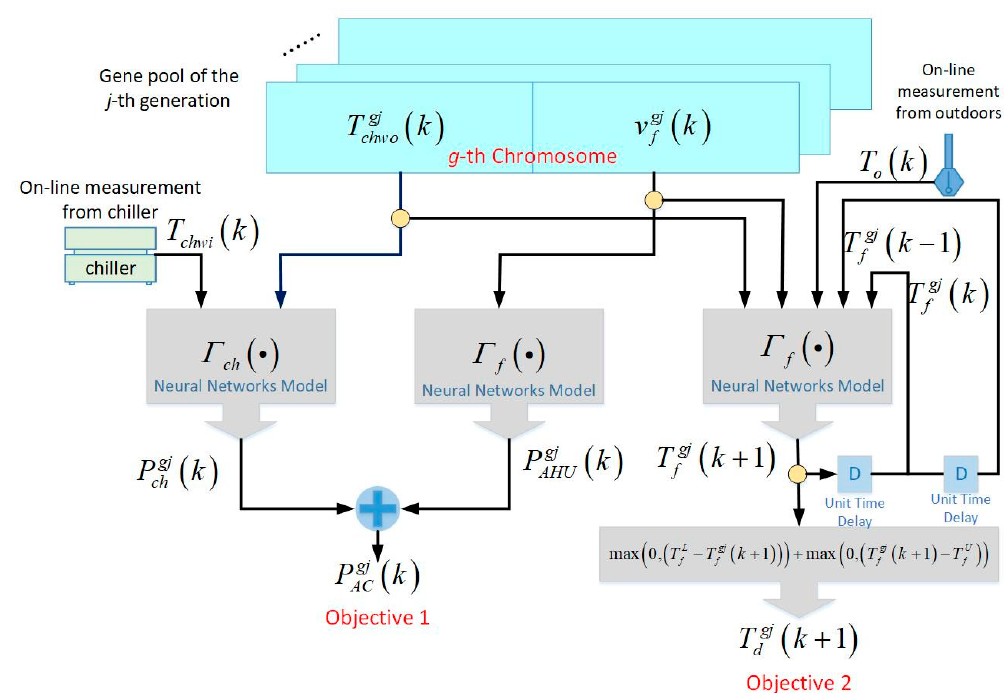
Figure 2. Illustration of fitness value calculation for the chromosome in the gene pool.